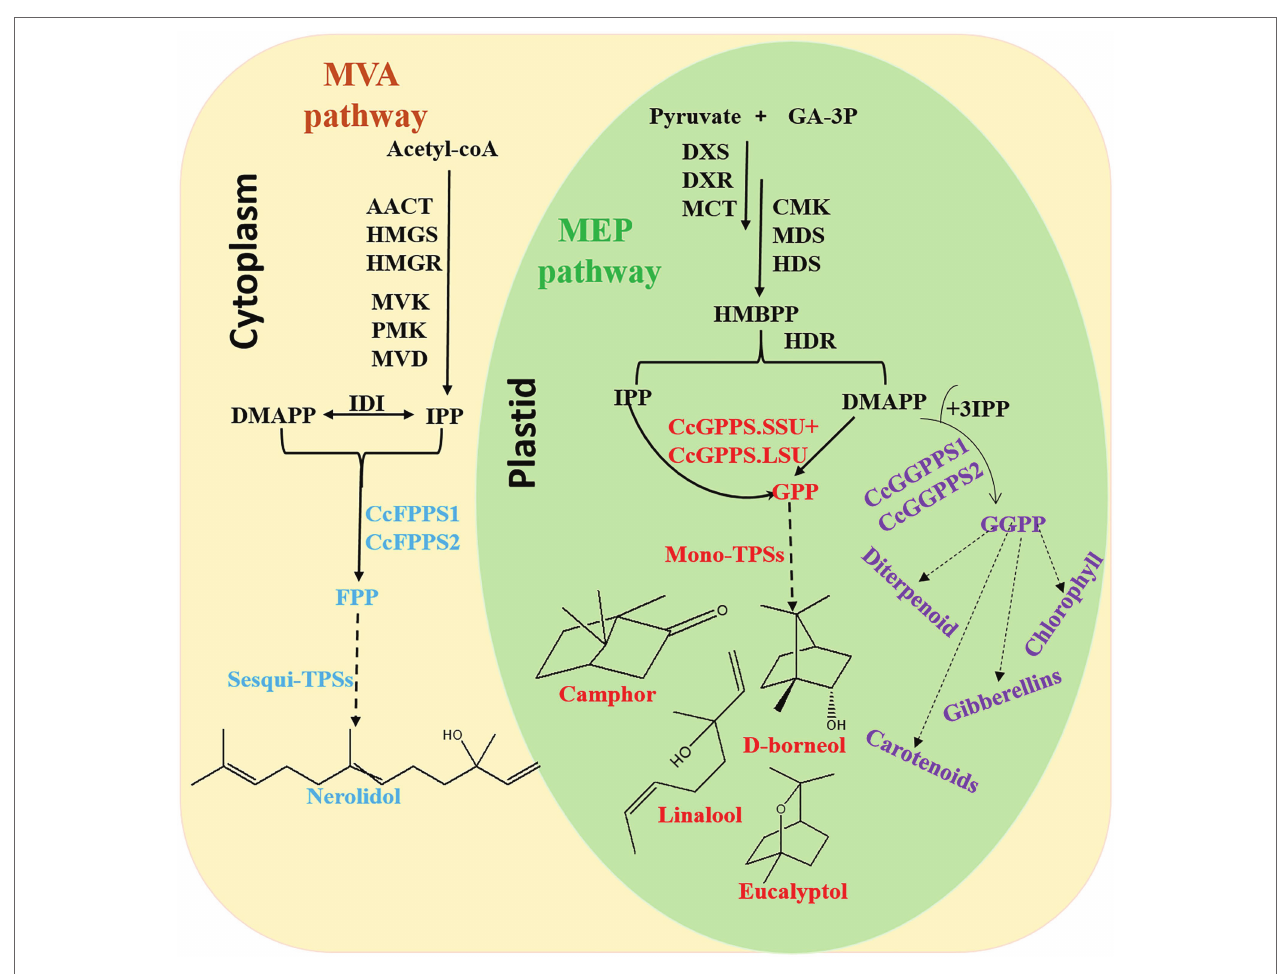
FIGURE 9 | Overview of the terpenoid biosynthesis pathway in C. camphora . AACT, acetoacetyl-coenzyme A thiolase; HMGS, 3-hydroxy-3-methylglutaryl coenzyme A synthase; HMGR, 3-hydroxy-3-methylglutaryl coenzyme A reductase; MVK, mevalonate kinase; PMK, 5-phospho mevalonate kinase; MVD, mevalonate diphosphate decarboxylase; IDI, isopentenyl diphosphate isomerase; FPPS, farnesyl diphosphate synthase; DXS,1-deoxy-D-xylulose-5-phosphate synthase; DXR,1-deoxy-D-xylulose-5-phosphate reductoisomerase; MCT, 2-C-methyl-D-erythritol-4-(cytidyl-5-diphosphate) transferase; CMK, 4-(cytidine50- diphospho)-2-C-methyl-D-erythritol kinase; MDS, 2-C-methyl-D-erythritol 2,4-cyclodiphosphate synthase; HDS,1-hydroxy-2-methyl-2-(E)-butenyl-4-diphosphate synthase; and HDR, 1-hydroxy-2-methyl-2-(E)-butenyl-4-diphosphate